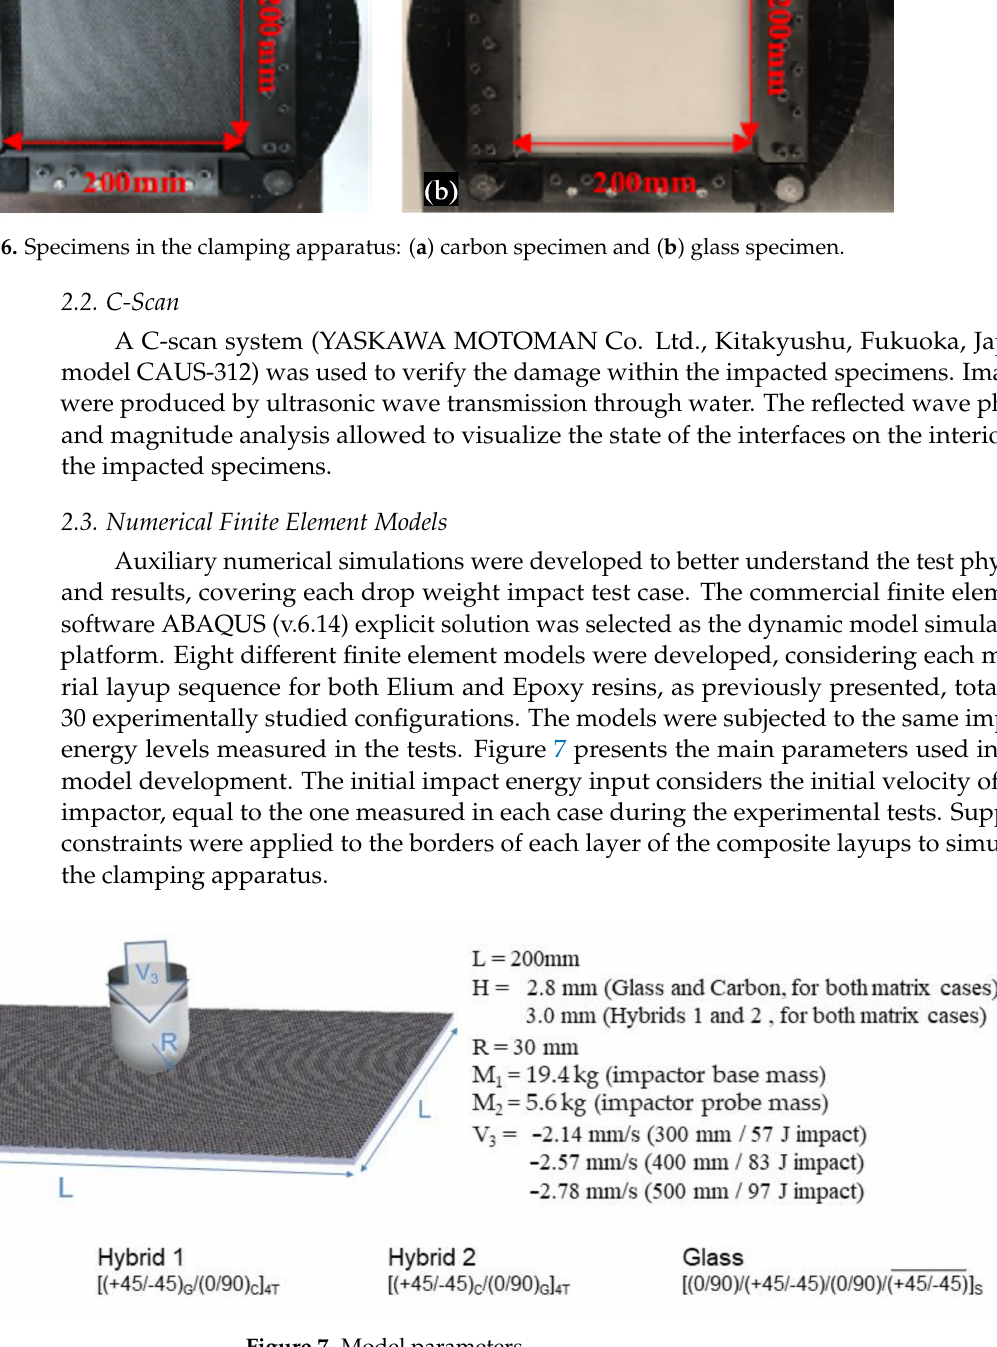
Figure 5. Specimen manufacturing process.